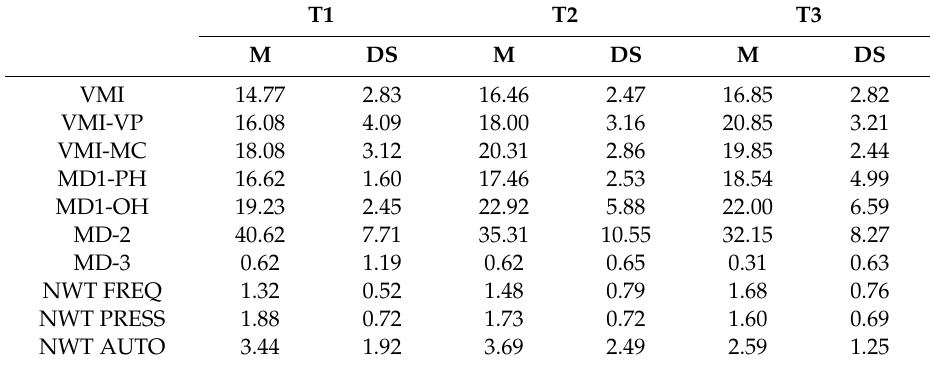
Table 3. Descriptive statistics of children performances on Beery Buktenica Visual Motor Integration Test, Fine Motor Tasks of the Movement ABC-2, and Name Writing Test performed on a digitizer. Data are presented as means and standard deviations of the children’s raw scores.